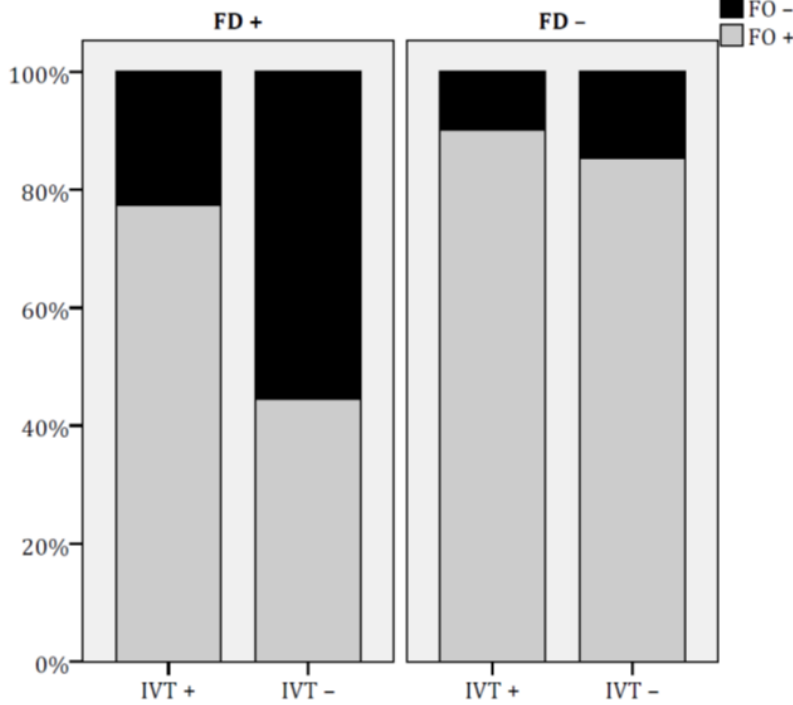
Figure 3. Effect of IVT on functional outcome rates in groups of patients with different levels of Figure 3. E ff ect of IVT on functional outcome rates in groups of patients with di ff erent levels of functional dependence at admission. FO= functional outcome; FD = functional dependence; IVT functional dependence at admission. FO = functional outcome; FD = functional dependence; IVT = = intravenous thrombolysis. intravenous